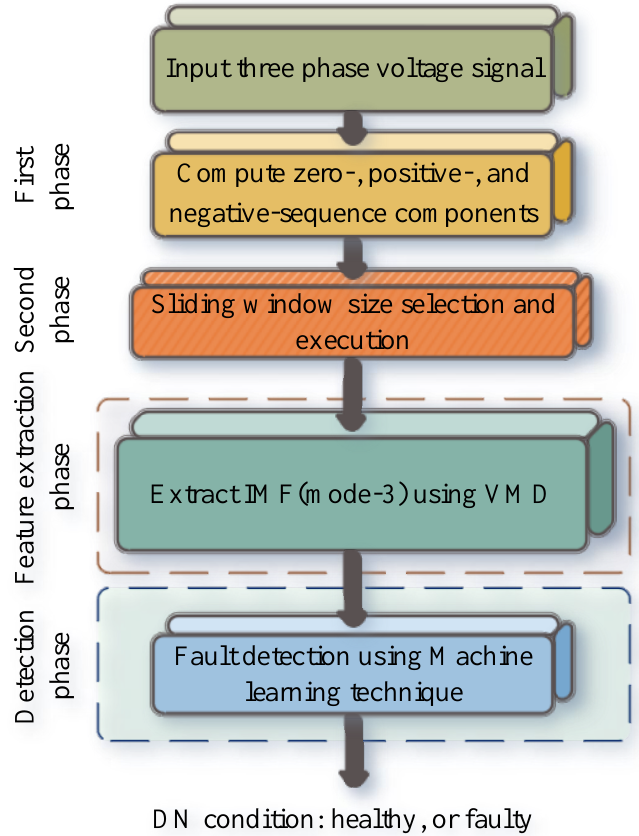
Figure 2. The overall flow chart of the proposed